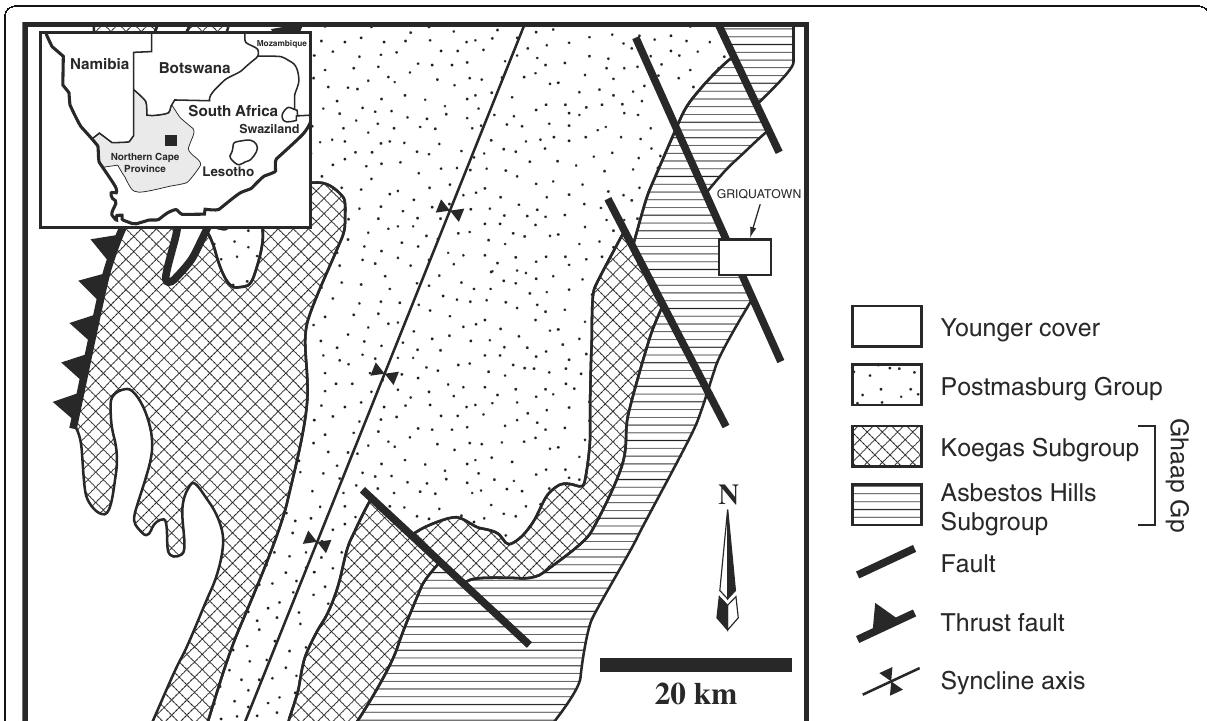
Fig. 1 Simplified geological map of the Transvaal Supergroup, Northern Cape Province, South Africa (modified after Gutzmer et al.